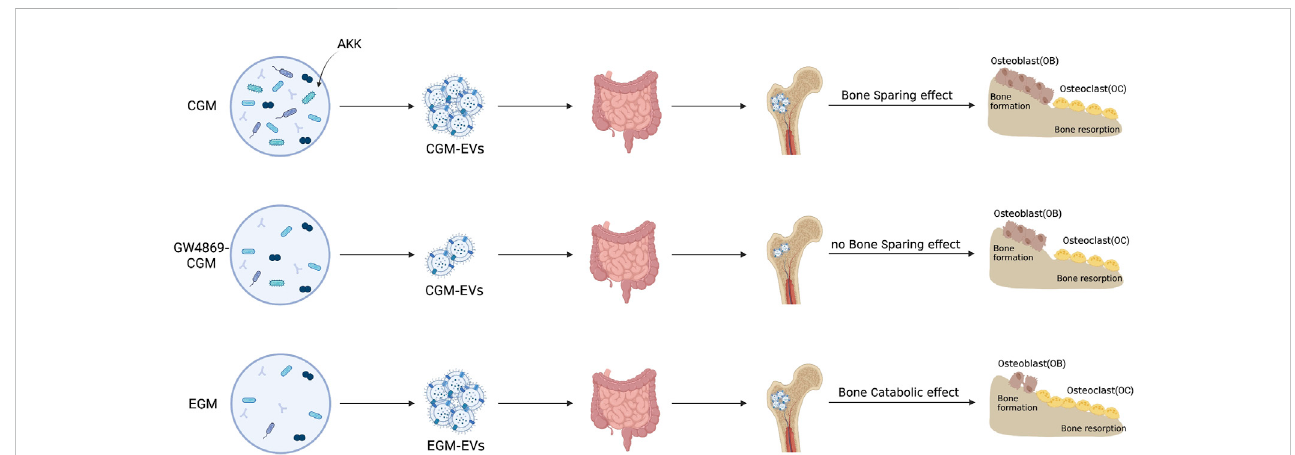
FIGURE 2 OP is treated with natural BEVs. The direct intervening OVX animals shown in the schematic diagram may operate similarly to their parent bacteria in promoting osteoblast growth and suppressing osteoclast activity, suppressing the loss of bone mass and strength, and the degeneration of the